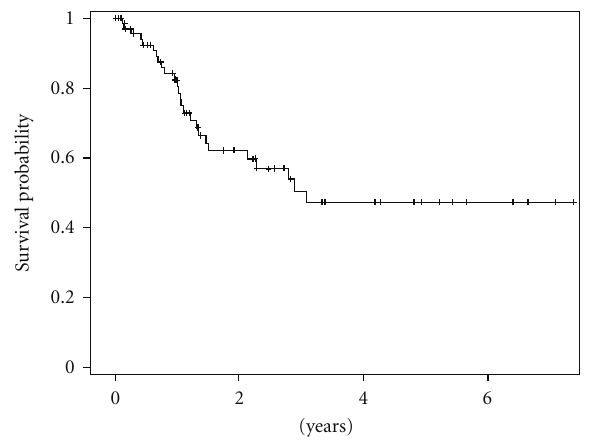
Figure 1: Overall disease-free survival for patients with advanced recurrent cutaneous squamous cell carcinoma.